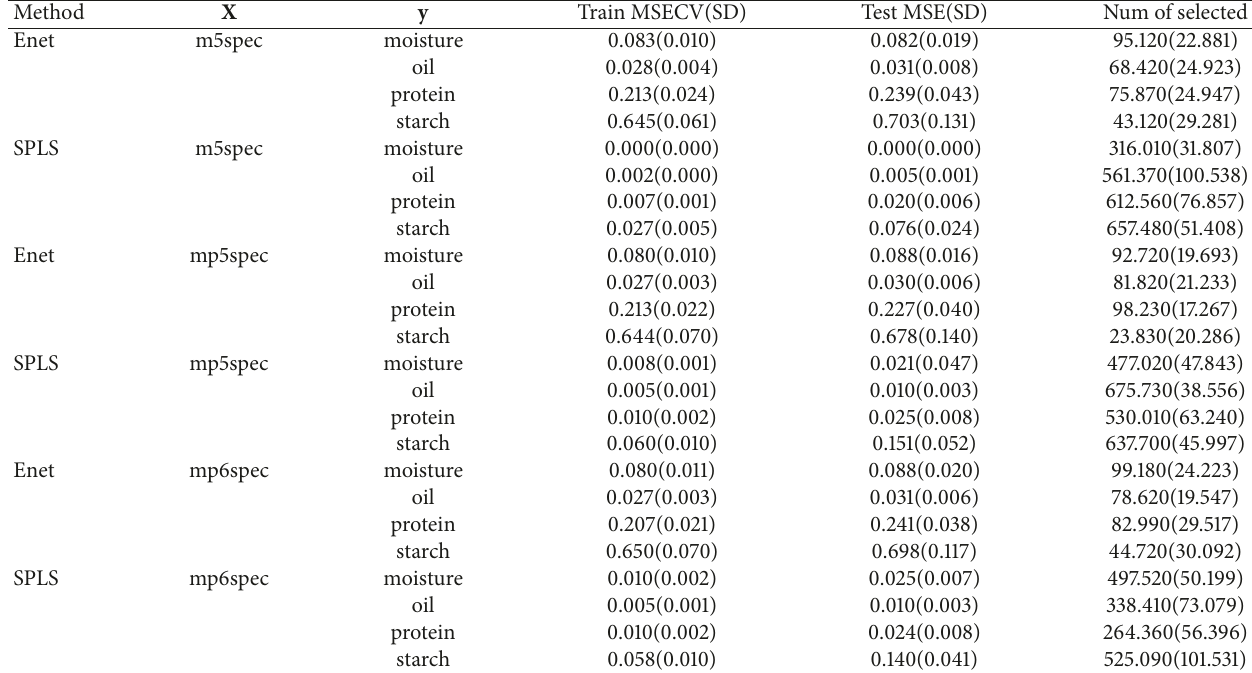
Table 3: The results on “corn” data set based on 100 replications.